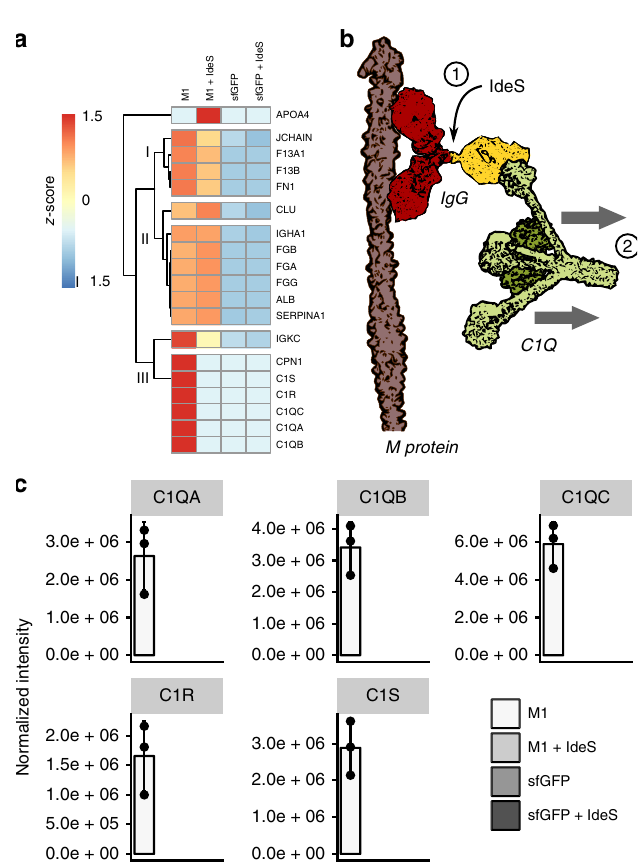
Fig. 6 Plasma IdeS pre-treatment in AP – DIA. a Cluster analysis based on z - score of the M1 protein AP – DIA data in human plasma and IdeS pre-treated human plasma. sfGFP was used as a negative control. b Plasma IdeS cleavage counteracts IgG-mediated C1Q attachment to the M1 protein. c Effect of plasma IdeS pre-treatment on complement C1Q, C1R, and C1S binding to the M1 protein. Error bars are expressed as standard deviation (s.d.) from the mean. All experiments were prepared using n = 3 biologically independent samples. Source data are provided as a Source Data fi